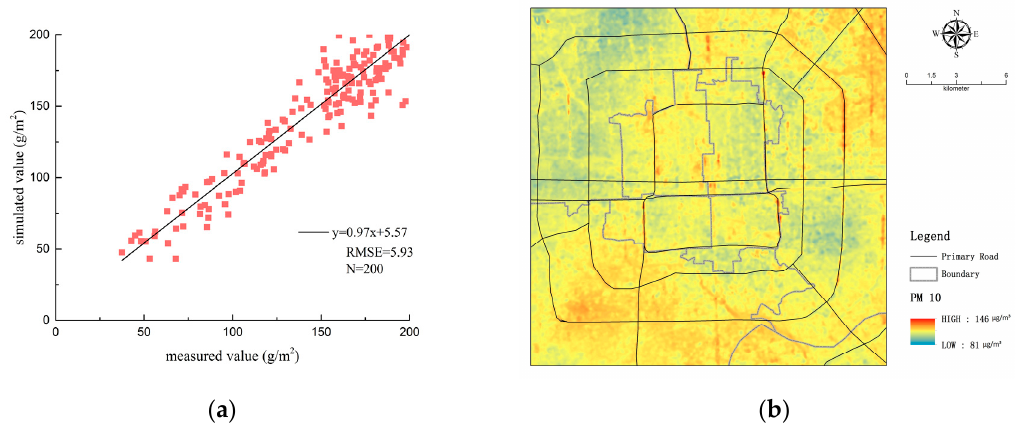
Figure 9. ( a ) Inversion precision with reference to measured data of foliar dust and ( b ) spatial distribution of particulate matter with diameter less than 10 μ m (PM 10 ).